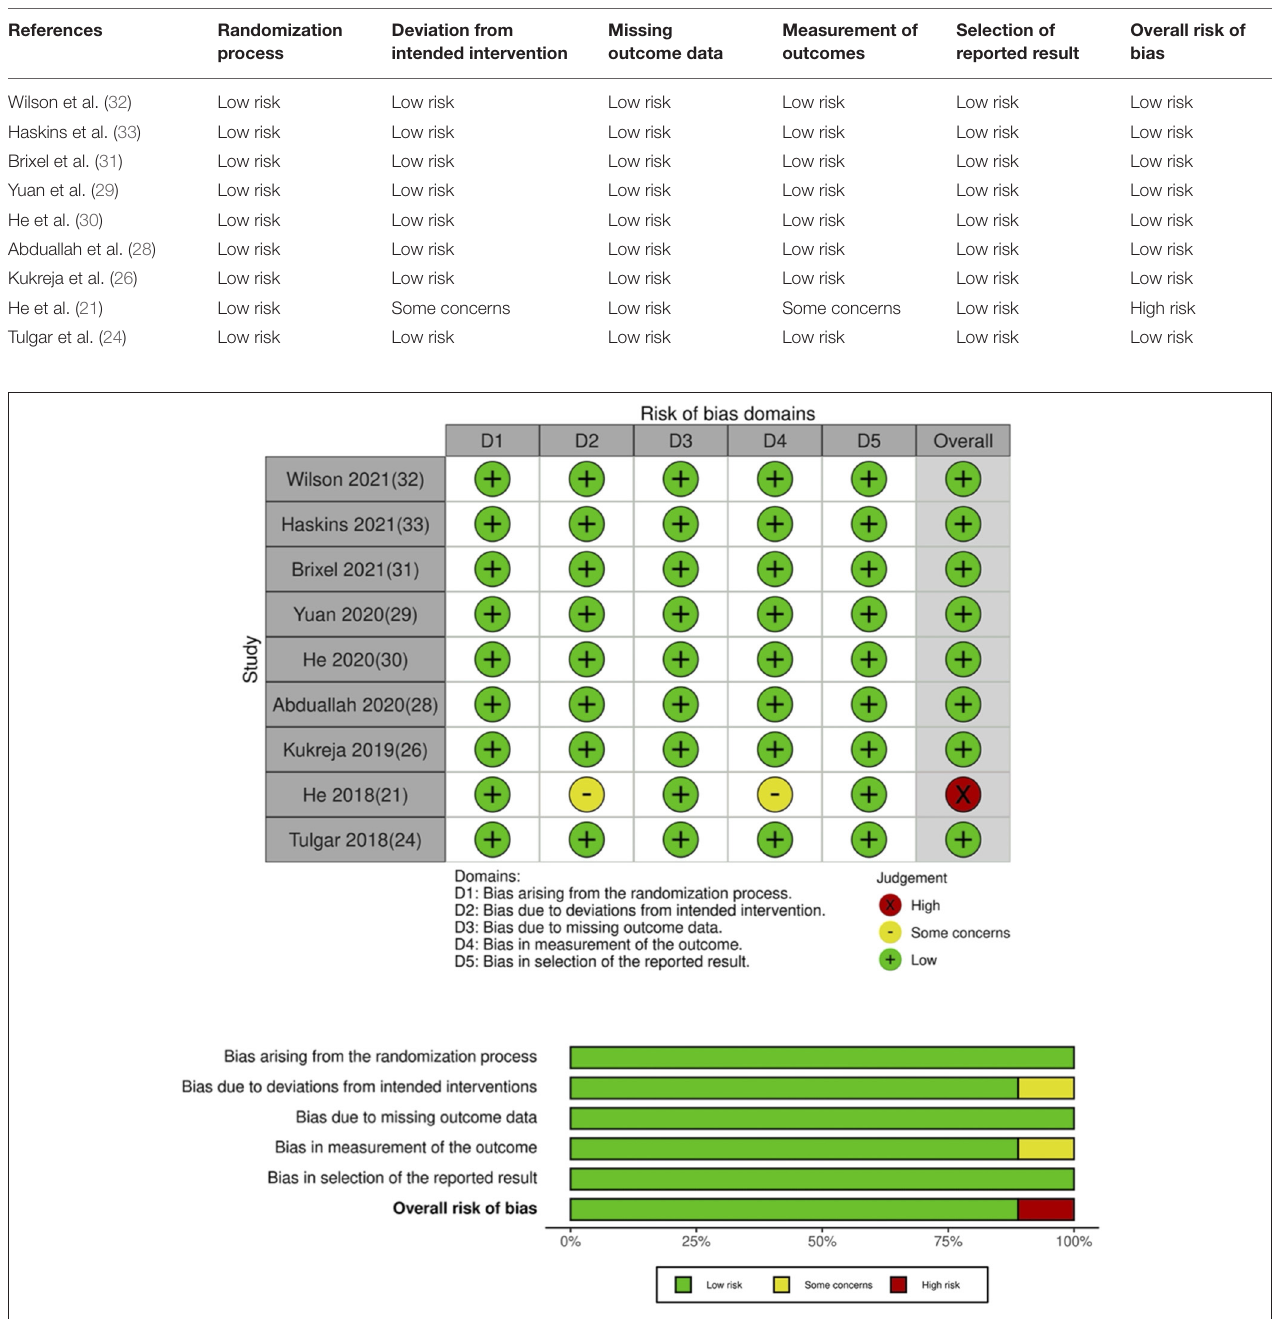
TABLE 2 | Risk of bias in included RCTs.